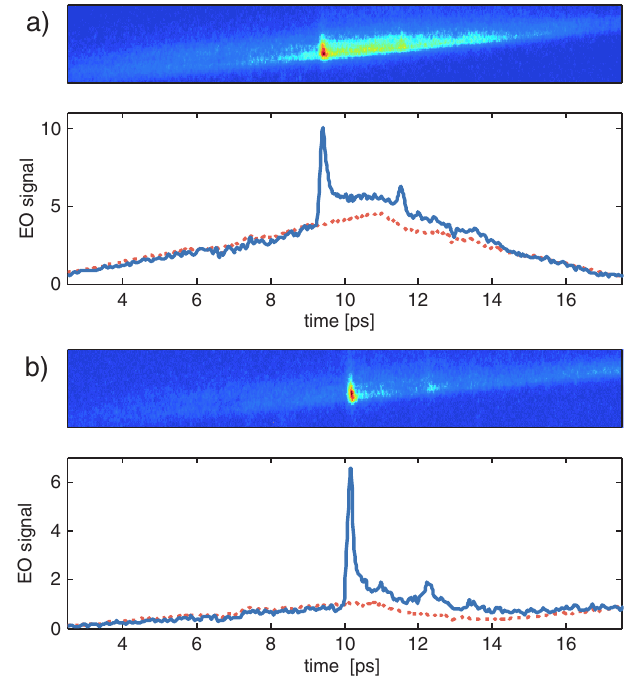
FIG. 12. (Color) Intensified CCD camera images of temporally resolved EO signals and the corresponding signal traces (solid blue curves). Shown are the raw data, only the camera back- ground is subtracted. The traces obtained without electron beam are shown by the dotted red curves. (a) Measurement near crossed polarization, at an angle (cid:6) ¼ 1 (cid:3) of the half-wave plate. (b) Measurement at crossed polarization, (cid:6) ¼ 0 . The leading edge of the bunch is on the left. The small second spike positioned 2.2 ps behind the main spike is caused by the internal reflection of the THz pulse in the 100 (cid:1) m thick GaP